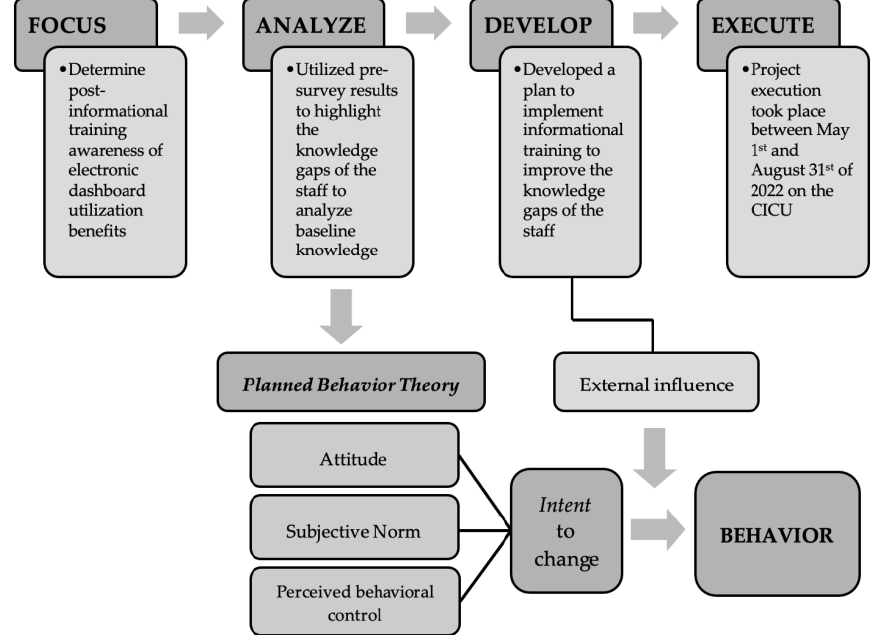
Figure 1. Adapted from FADE Model and Theory of Planned Behavior [9–12]. Reprinted/adapted from Ref. [https://josieking.org/patientsafety/module_a/methods/fade.html]. 2002–2021, Duke University.